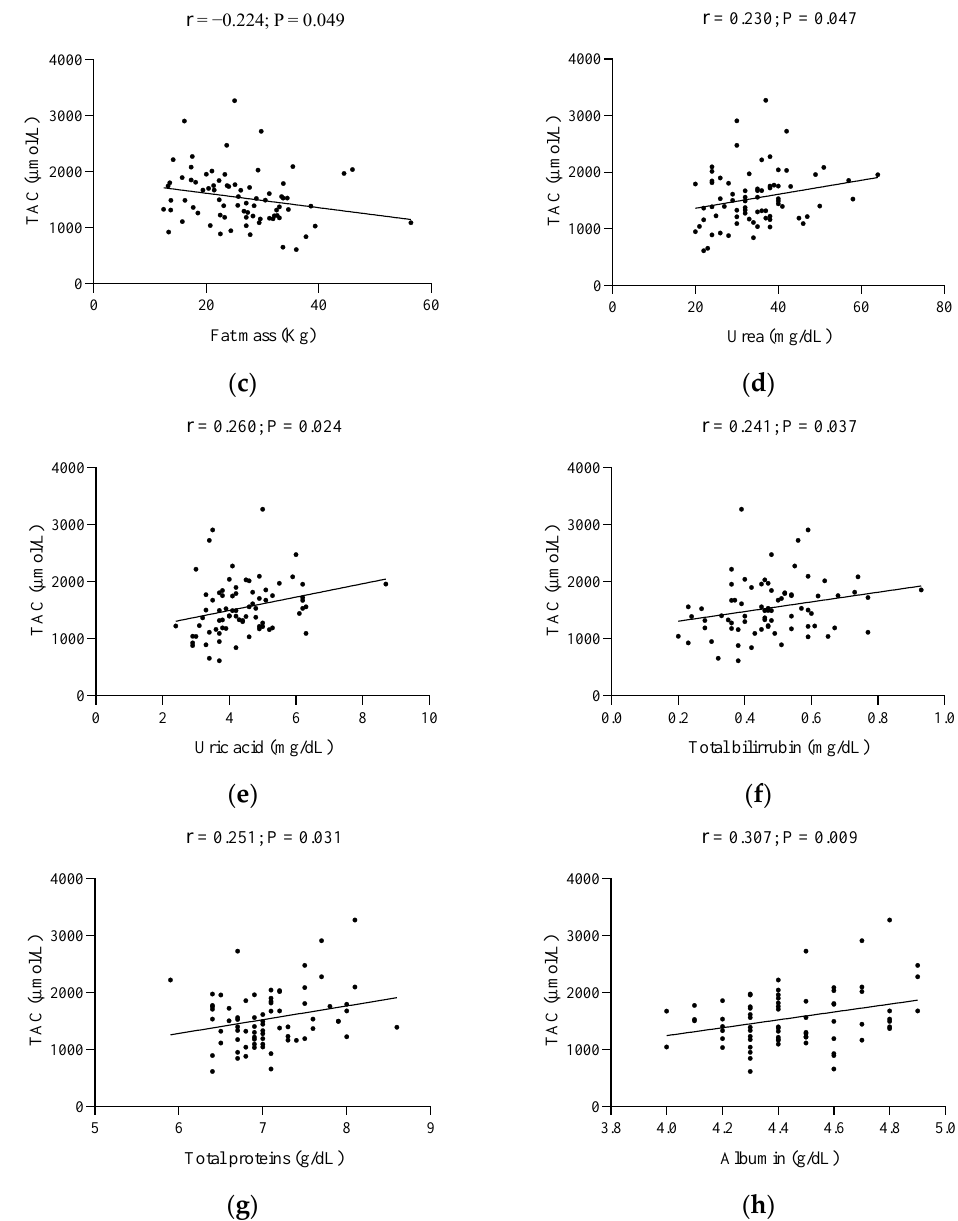
Figure 1. Significant associations of the body composition and biochemical parameters of the study with TAC. ( a ) weight and TAC, ( b ) hip perimeter and TAC, ( c ) fat mass and TAC, ( d ) urea and TAC, ( e ) uric acid and TAC, ( f ) total bilirubin and TAC, ( g ) total proteins and TAC, and ( h ) albumin and TAC. r, Pearson’s correlation coefficient. Abbreviations: TAC, total antioxidant capacity. A p -value less than 0.05 was considered significant.